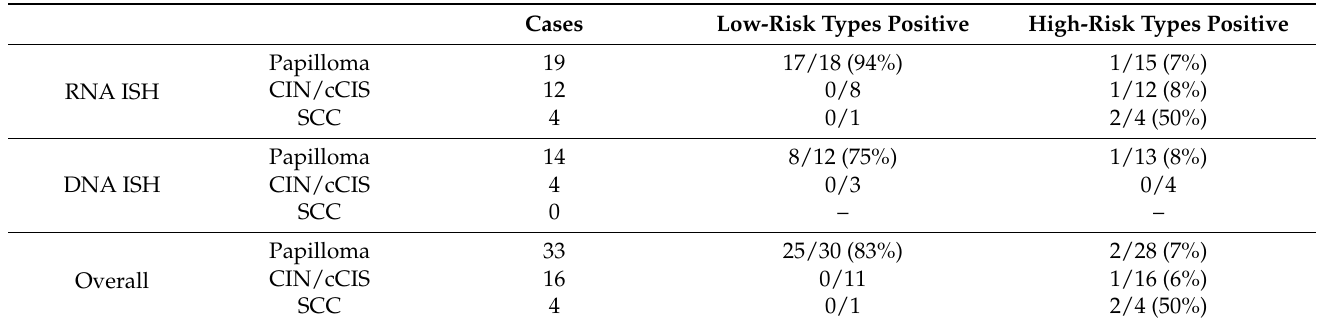
Table 2. HPV Detection in Conjunctival Papillomas and